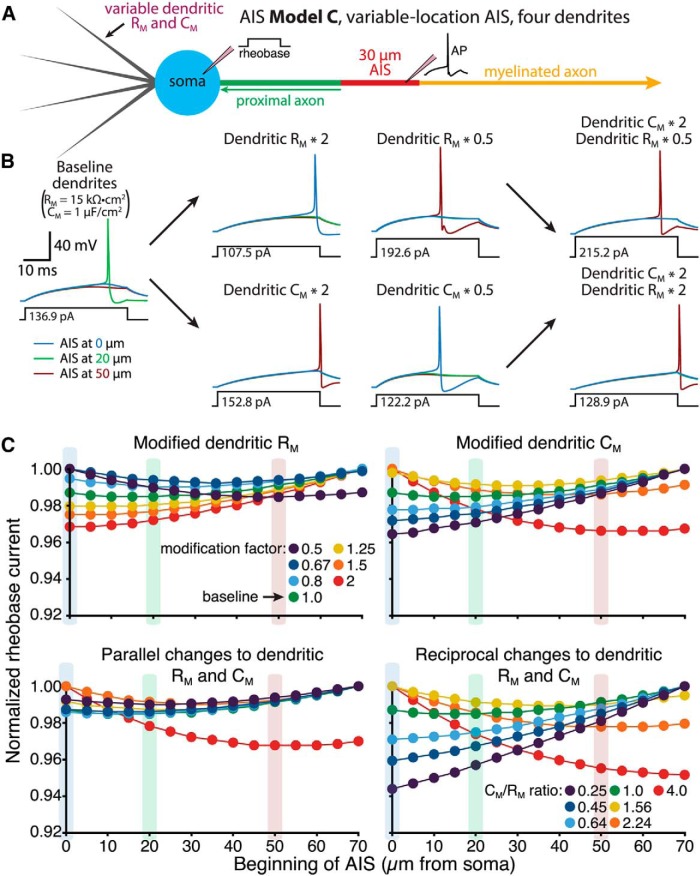
Dendritic membrane properties influence optimal AIS location relative to the soma. A, Diagram of a neuron with four dendrites having variable dendritic membrane properties and a 30 µm AIS positioned at variable distances from the soma (AIS Model C; myelinated axon). B, Voltage responses in the AIS during somatic current injections under baseline conditions (far left) and after manipulations of dendritic RM and/or CM, as indicated. Responses from three models are superimposed: those having the AIS beginning 0 (blue), 20 (green), or 50 µm (red) from the soma. C, Plots of normalized rheobase current vs AIS location for the four-dendrite models having modified dendritic RM (top left), dendritic CM (top right), parallel changes in both dendritic RM and CM (bottom left), or reciprocal changes in dendritic properties (bottom right). Dendritic CM and/or RM were multiplied by the indicated modification factors. CM/RM ratios in reciprocal manipulations of RM and CM are centered around baseline (CM/RM ratio = 1) values. Increasing dendritic CM and/or dendritic conductance (lower dendritic RM) enhanced excitability at more distal AIS locations. Shaded bars indicate the AIS locations for which traces are shown in B.